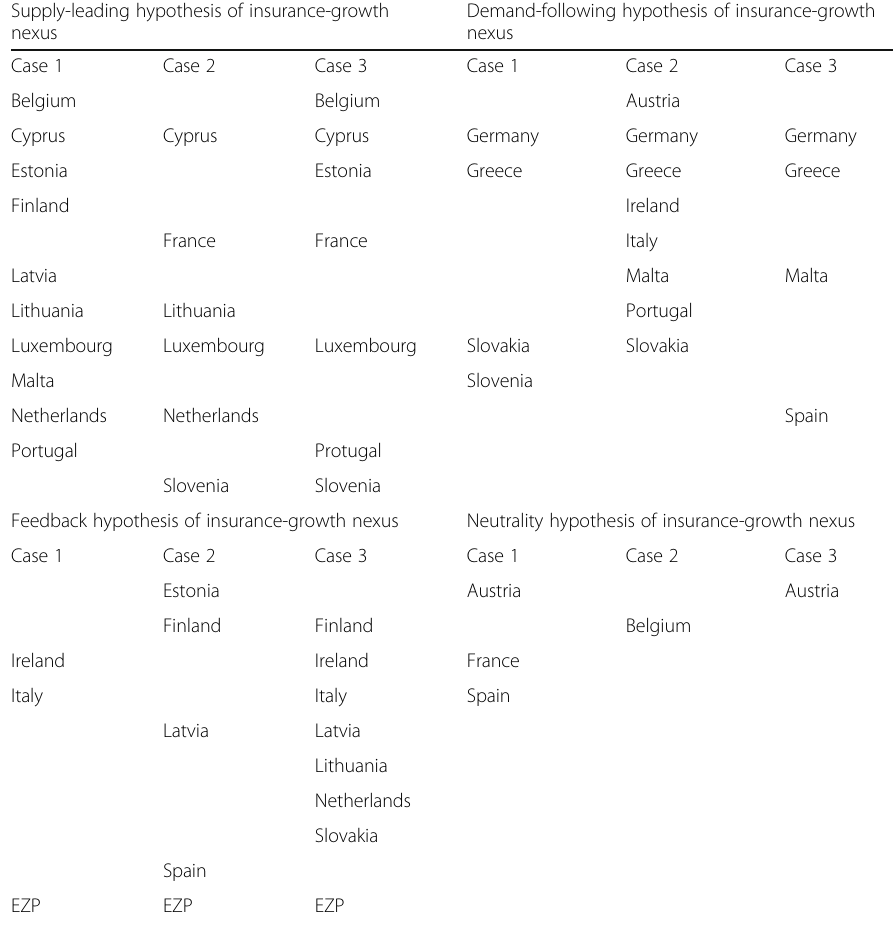
Table 7 Summary of Granger Causality Test